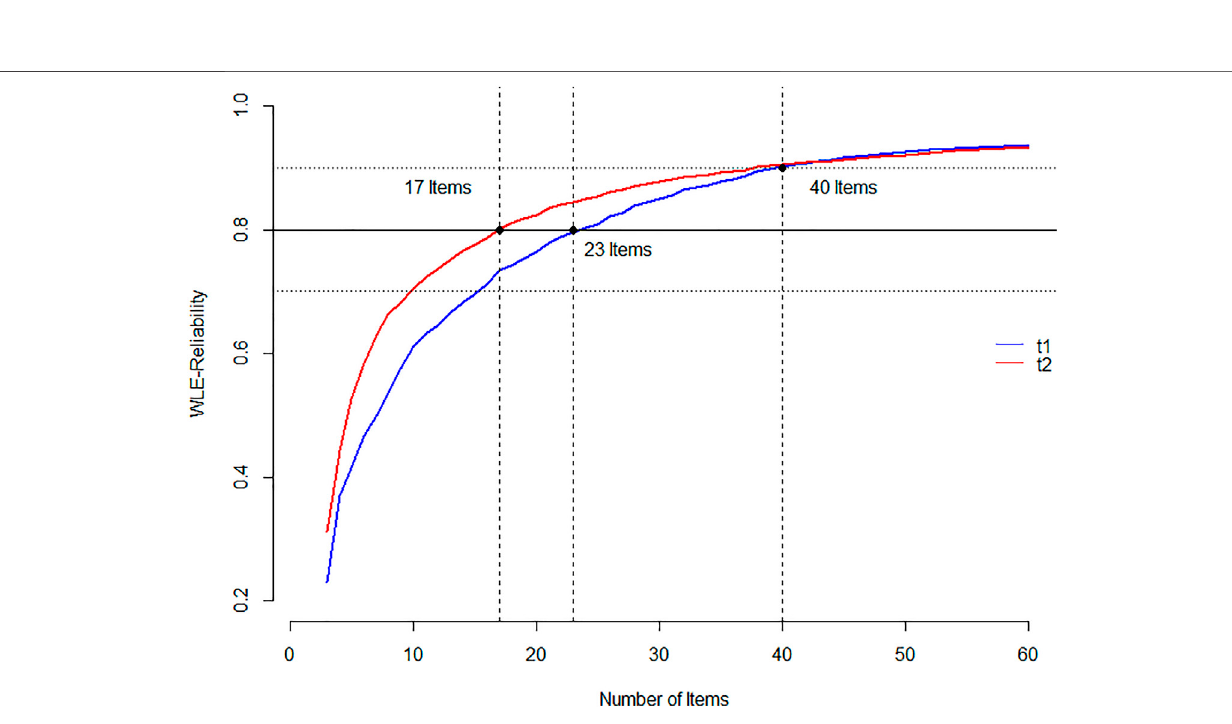
FIGURE 5 | WLE Reliability by number of items of the